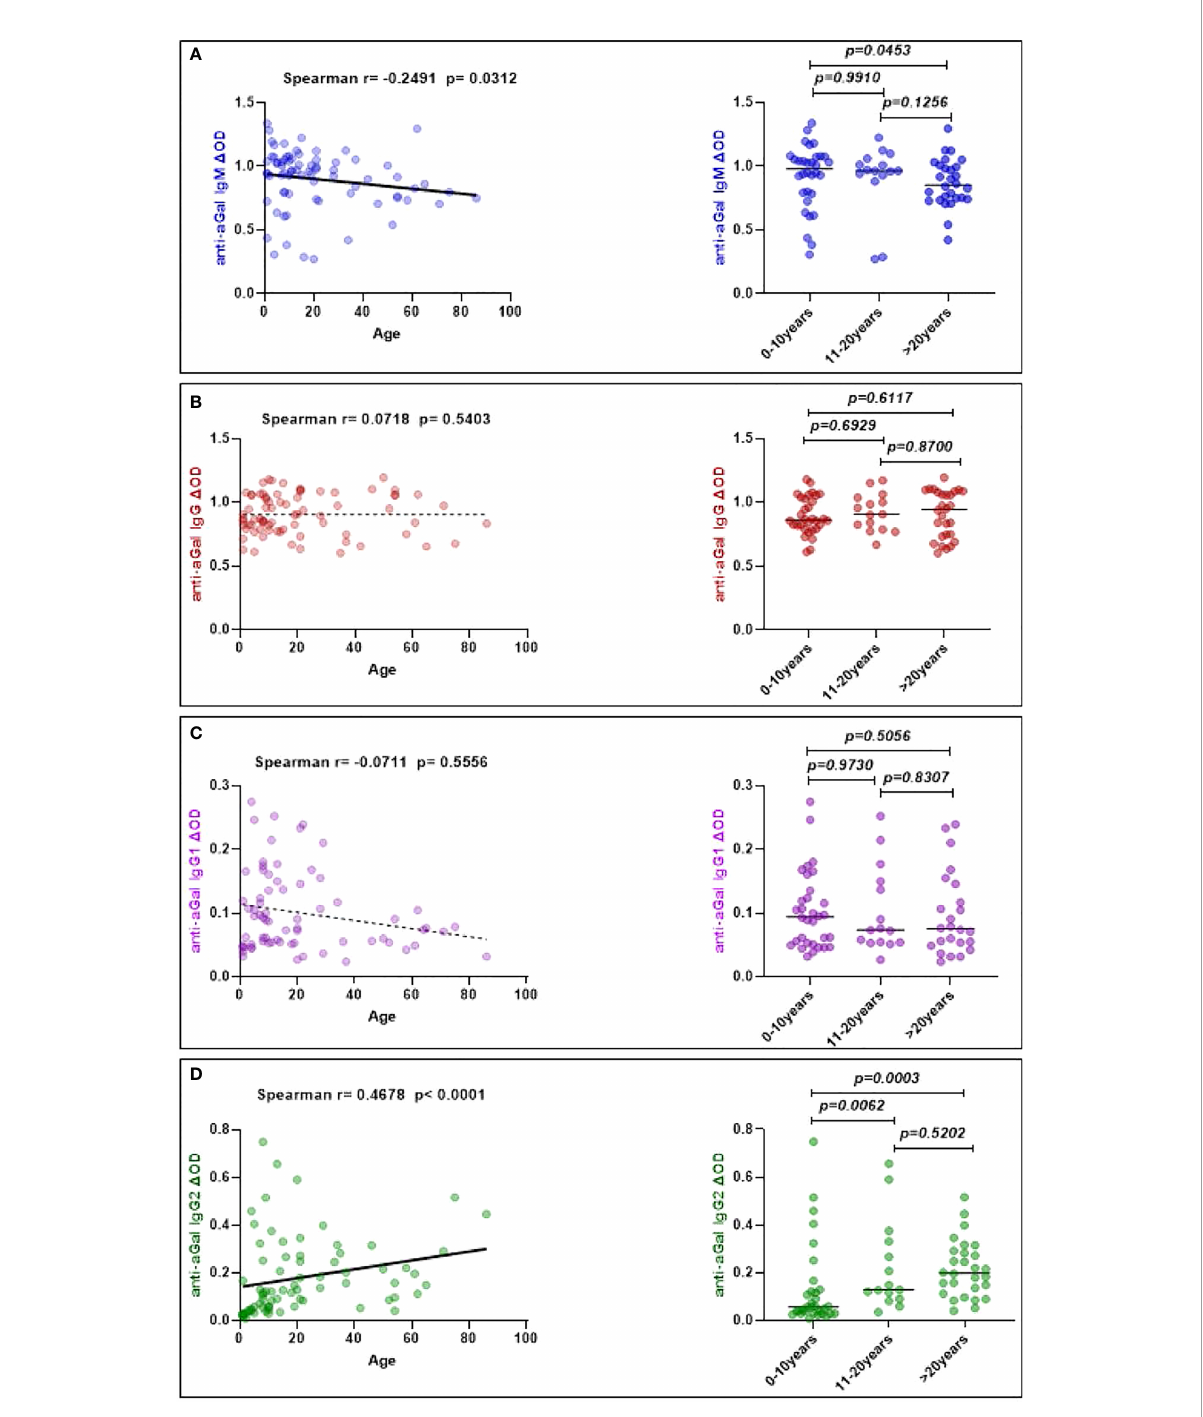
FIGURE 5 Correlation of speci fi c anti- aGal IgM, IgG, IgG1, and IgG2 antibody levels with dengue patients ’ age. (A) Blue color - anti-aGal IgM antibody levels. (B) Brown color - anti-aGal IgG antibody levels. (C) Purple color - anti-aGal IgG1 antibody levels. (D) Green color - anti-aGal IgG2 antibody levels. The left panel represents a correlation plot of anti-aGal antibodies with age. Regression lines in each graph are shown by solid lines for p<0.05 and dotted lines for non-signi fi cant. Both “ r ” and “ p ” values were obtained from the non-parametric Spearman correlation test. While right panel represent anti-aGal antibody with age distribution (0-10 years (n=32), 11-20 years (n=15), and >20 years (n=28)). Anti-aGal antibody levels are represented by the colored dots and horizontal black lines represent medians of group individual antibody responses. The “ p ” values <0.05 were measured using the non-parametric Mann-Whitney